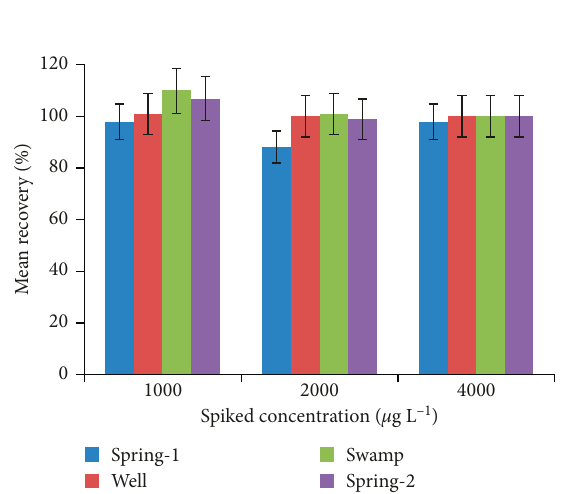
Figure 3: Mean recovery (average of all the analytes) for each water sample at three different spiked levels.